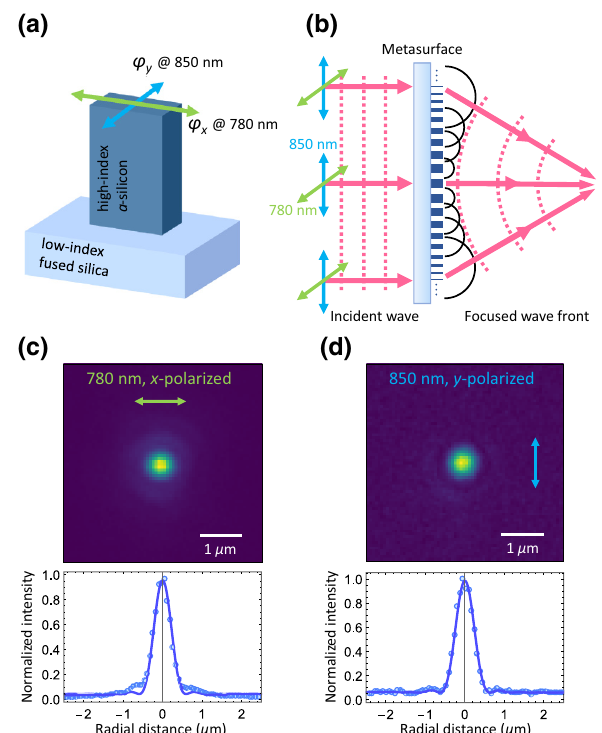
FIG. 6. The polarization-multiplexed metalens. (a) An a-Si nanopillar (dark blue) with a rectangular cross section on a fused- silica substrate (light blue) creates a phase delay for two orthog- onal polarizations independently (polarization multiplexing). (b) An illustration of the polarization-multiplexed metasurface-lens operation. The input wave front (pink dash) with orthogonal polarization for 780 nm (green) and 852 nm (blue) propagates and interacts with the metasurface. Secondary wavelets (black semicircles) reemitted by the nanopillars interfere and create identical focusing wave fronts for both 780 nm and 852